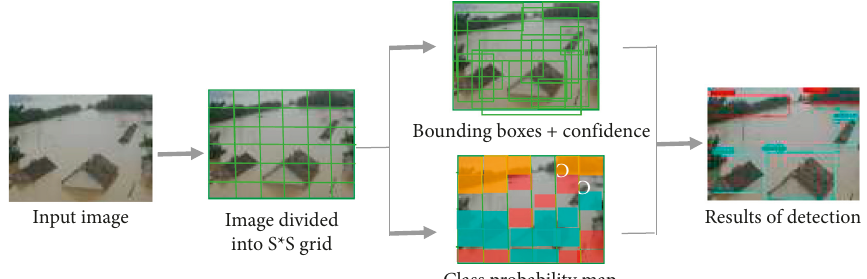
Figure 5: The relationship of UAV flight parameters.